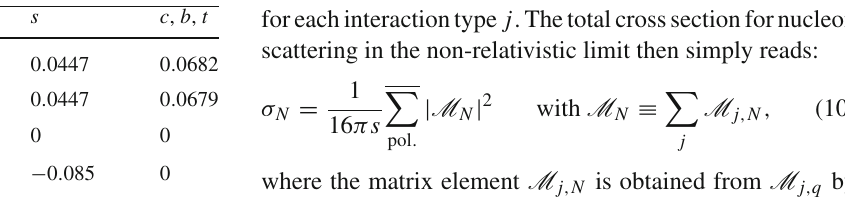
Table 1 Numerical values of the nucleonic matrix elements used in this work. Indicated in brackets are alternative names of the coefficients commonly used in the literature Quark flavor